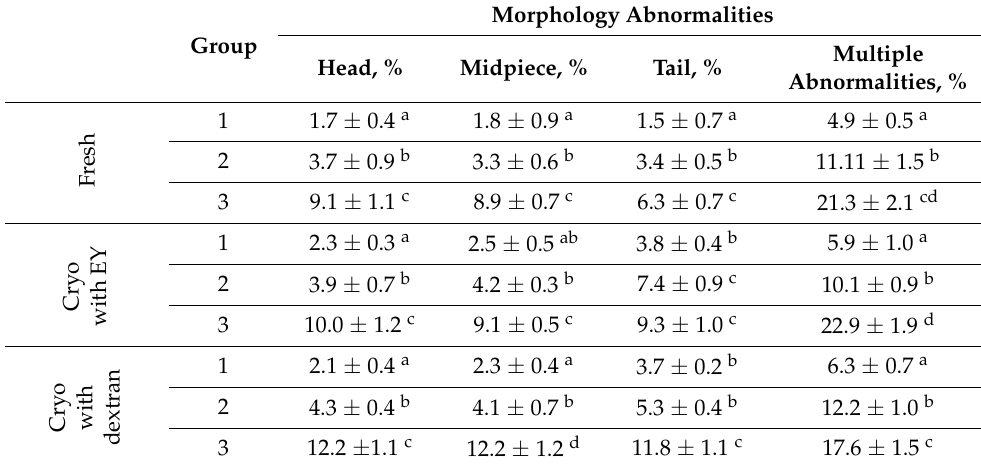
Table 2. Percentage of spermatozoa with various morphological abnormalities depending on the age of the dog and the type of extender.